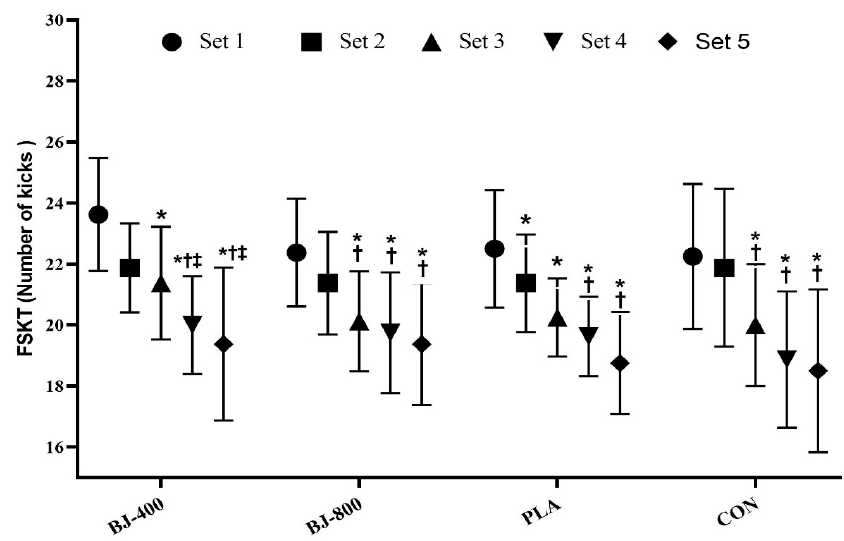
Figure 5. The number of kicks in five sets of Frequency Speed of Kick Test. Values are presented as mean and standard deviation. BJ, beetroot juice; PLA, placebo; CON, control. * Significant difference with Set 1 in same treatment ( p < 0.05). † Significant difference with Set 2 in same treatment ( p < 0.05). ‡ Significant difference with Set 3 in same treatment ( p < 0.05).